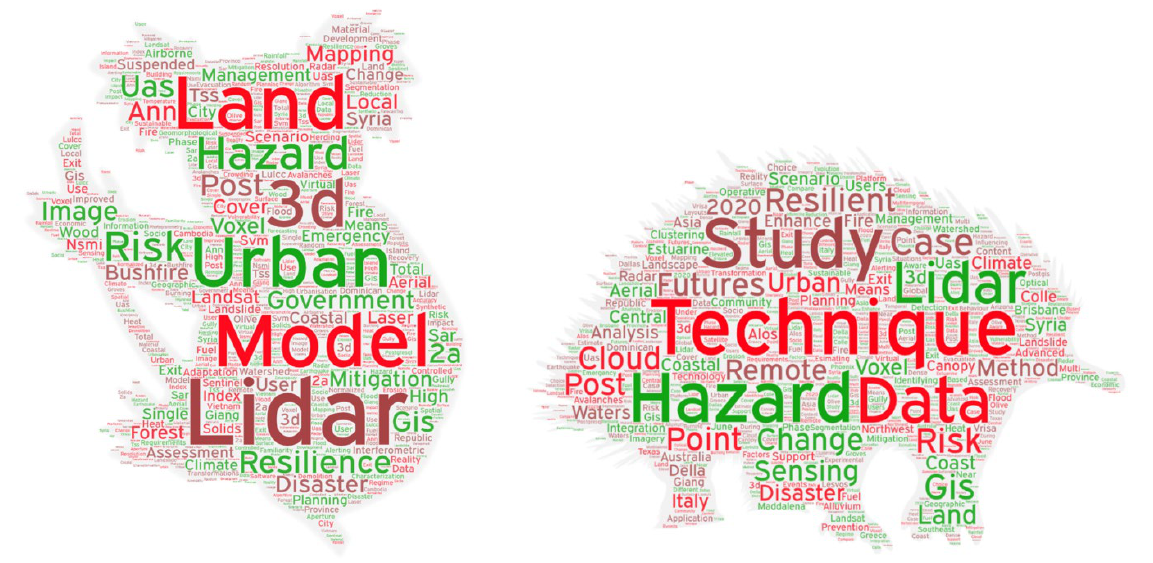
Figure 1: Word count of keywords (koala) and titles